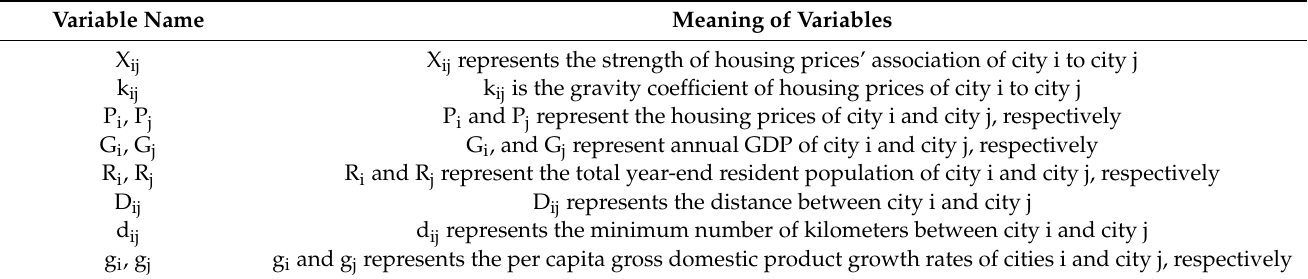
Table 1. Variables in the modified gravity